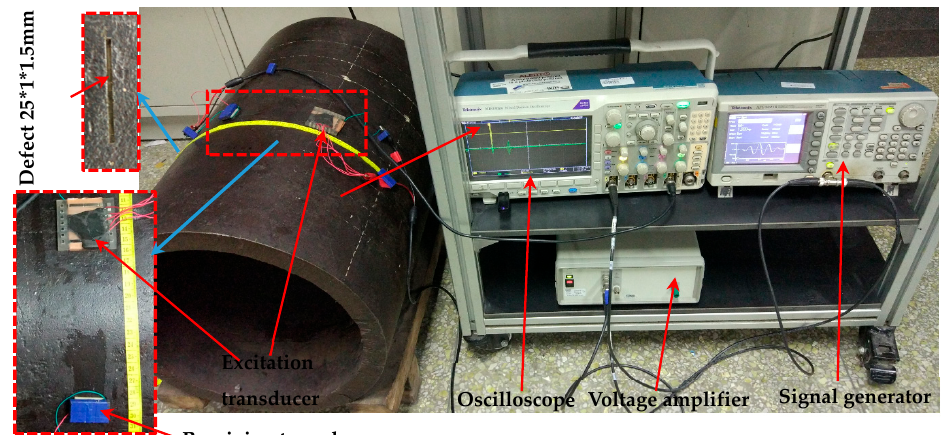
Figure 12. Thick-walled pipe defects testing equipment.